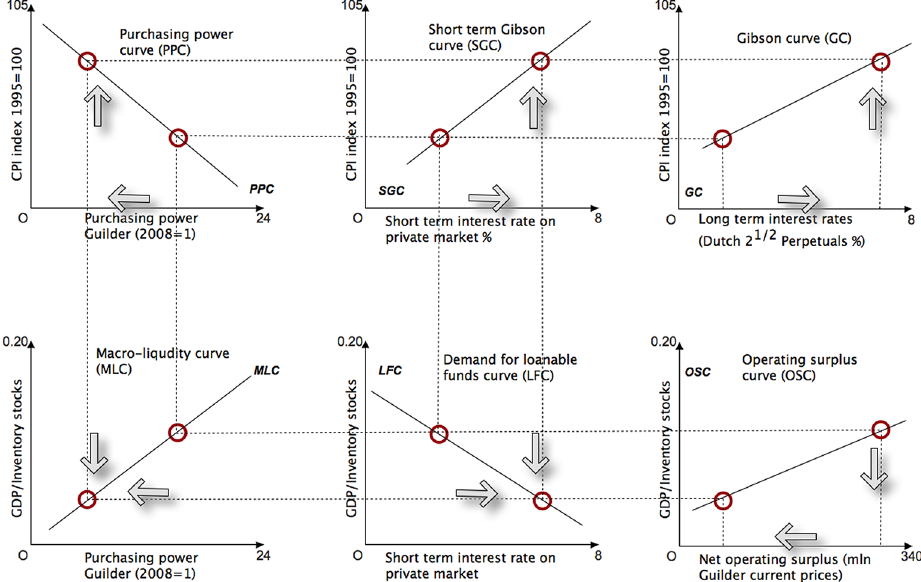
Fig. 1 . Gibson paradox curve model (the Netherlands 1800–1850) Source : authors’ calculation.